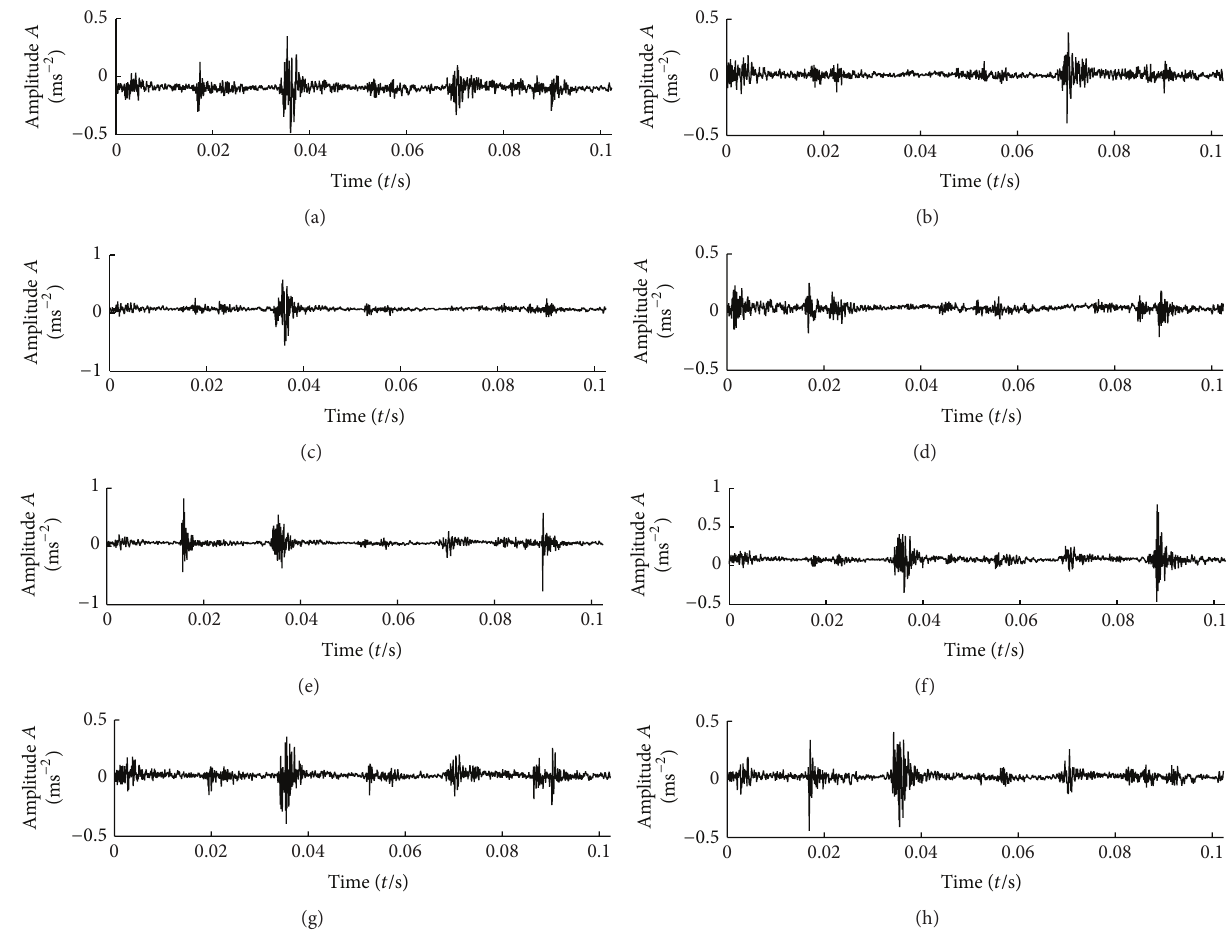
Figure 4: Vibration signals acquired from eight engine states: (a) normal state; (b) first cylinder misfire; (c) second cylinder misfire; (d) first and second cylinder misfire; (e) too large clearance of intake valve; (f) too large clearance of exhaust valve; (g) air leakage of the intake valve; (h) air leakage of the exhaust valve.